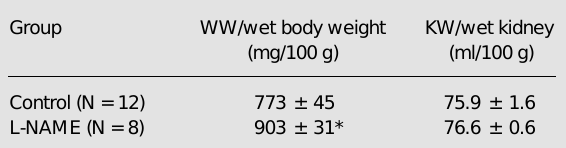
Table 2. Kidney weight and fluid distribution in response to